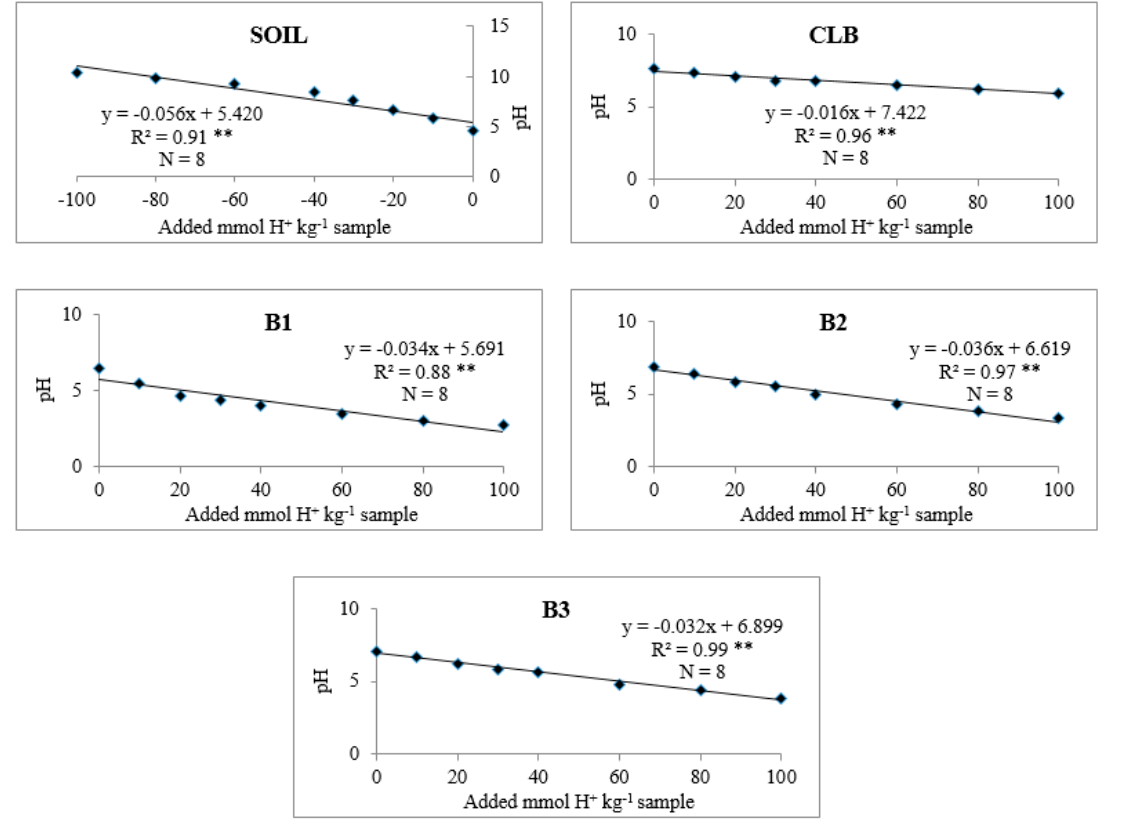
Figure 2. Linear regression between the added mmol H + kg − 1 sample and the pH of suspension show coe ffi cients of determination (R 2 ) > 0.73 and ** significant at P =